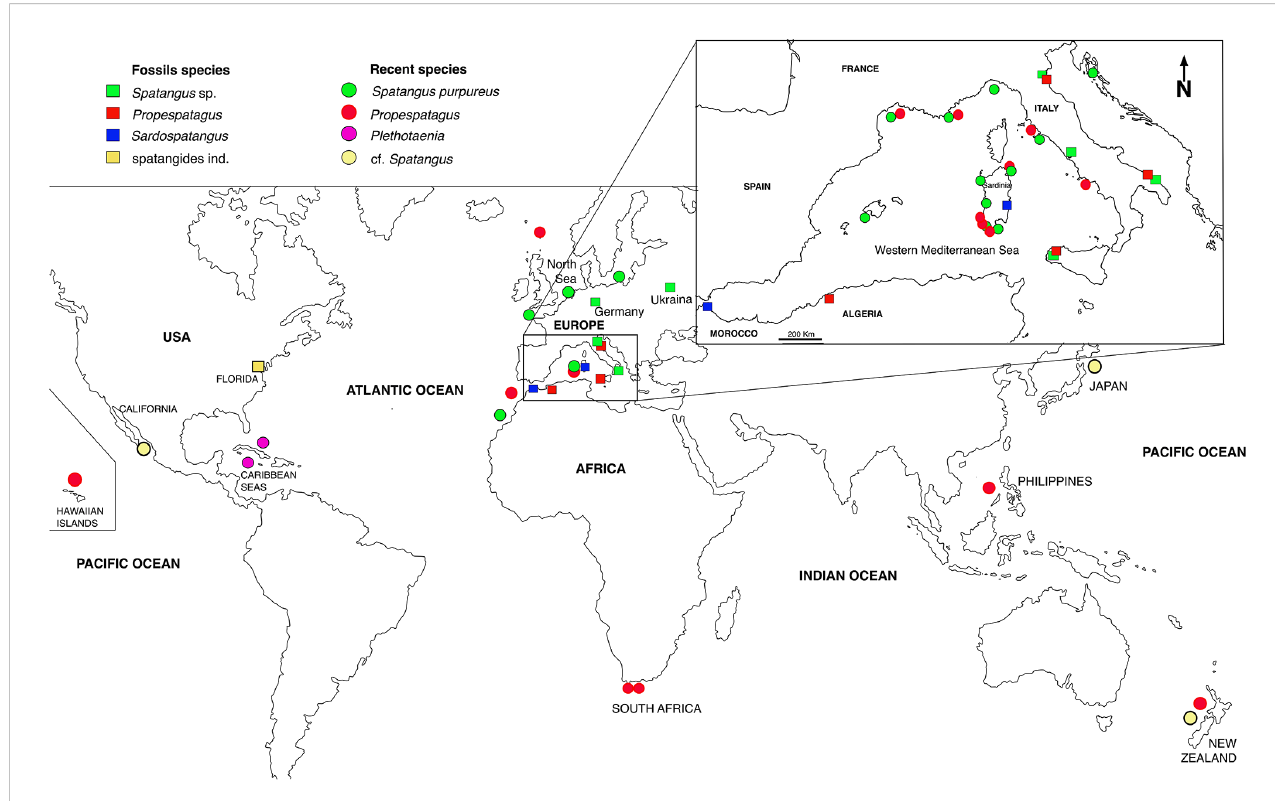
FIGURE 10 Geographical distribution of the analyzed